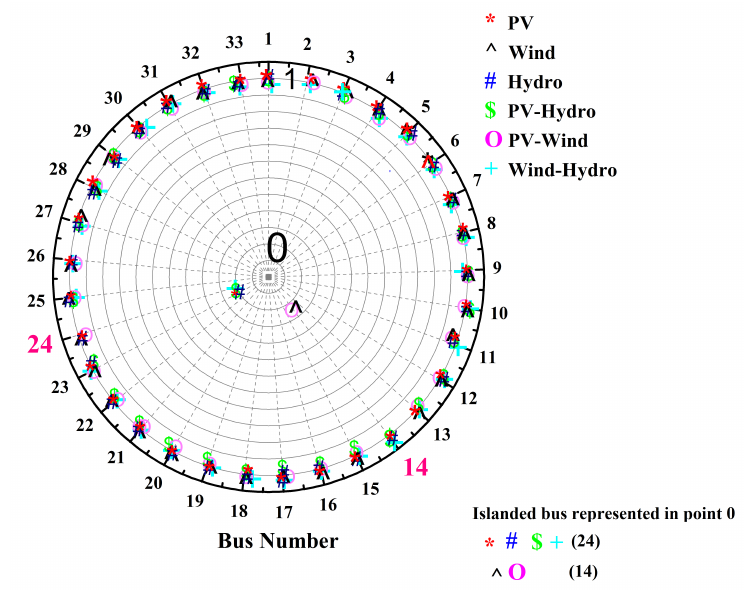
Figure 4. Detection of islanded buses- 33 bus